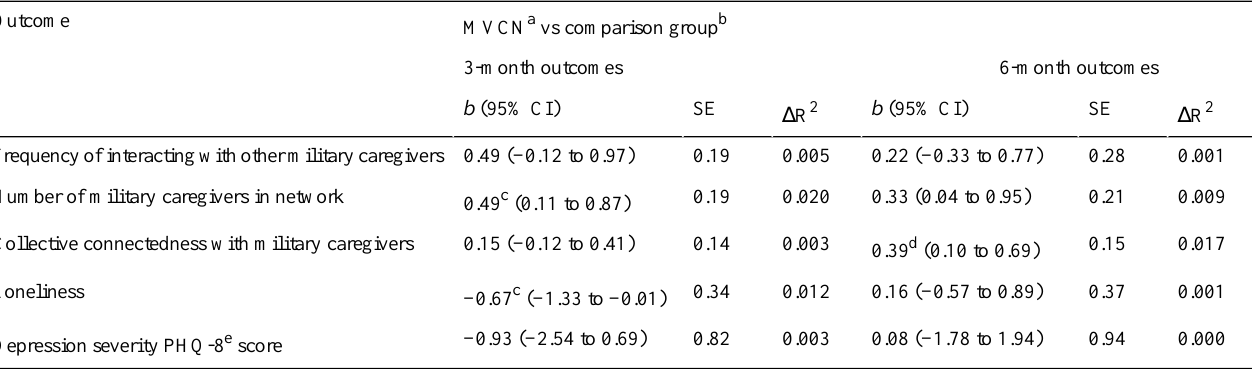
Table 2. Regression results predicting difference from baseline to 3-month outcomes and 6-month outcomes by membership in Military Veteran Caregiver Network vs comparison group (N=212).